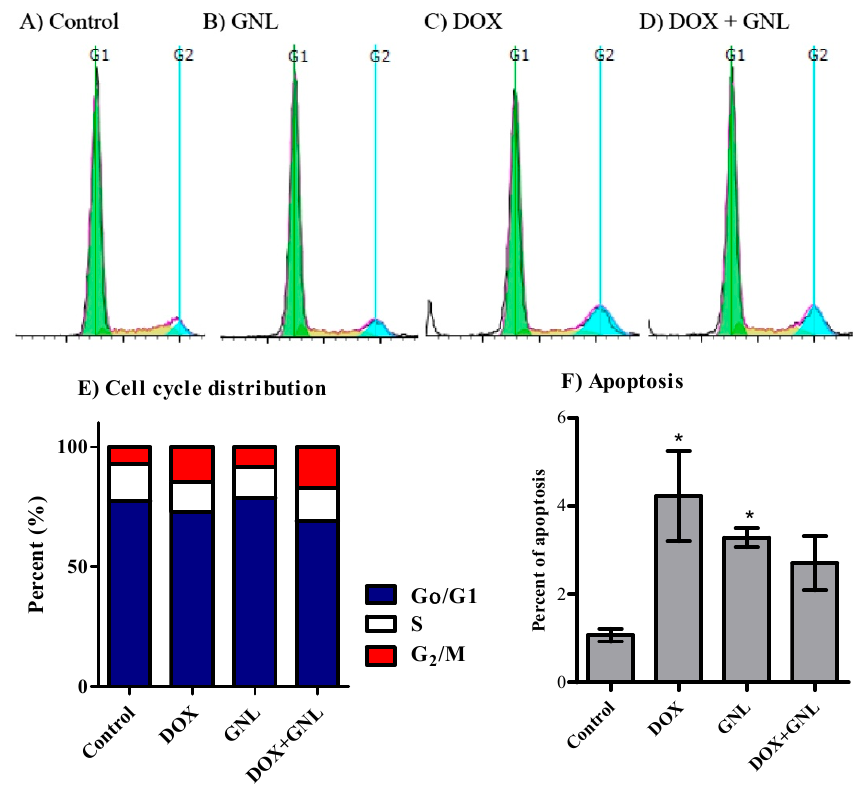
Figure 5. Effect of 6-gingerol (GNL) on the cell cycle distribution of HepG2 cells. The cells were exposed to GNL ( B ); DOX ( C ); or combination of GNL and DOX ( D ) for 24 h and compared to control cells ( A ); Cell cycle distribution was determined using DNA cytometry analysis and different cell phases were plotted ( E ) as percentage of total events; Sub-G cell population was taken as representative of late apoptosis/necrosis and was plotted as percent of total events ( F ). Data is presented as mean ± SD; n = 3. *: significantly different from control group.